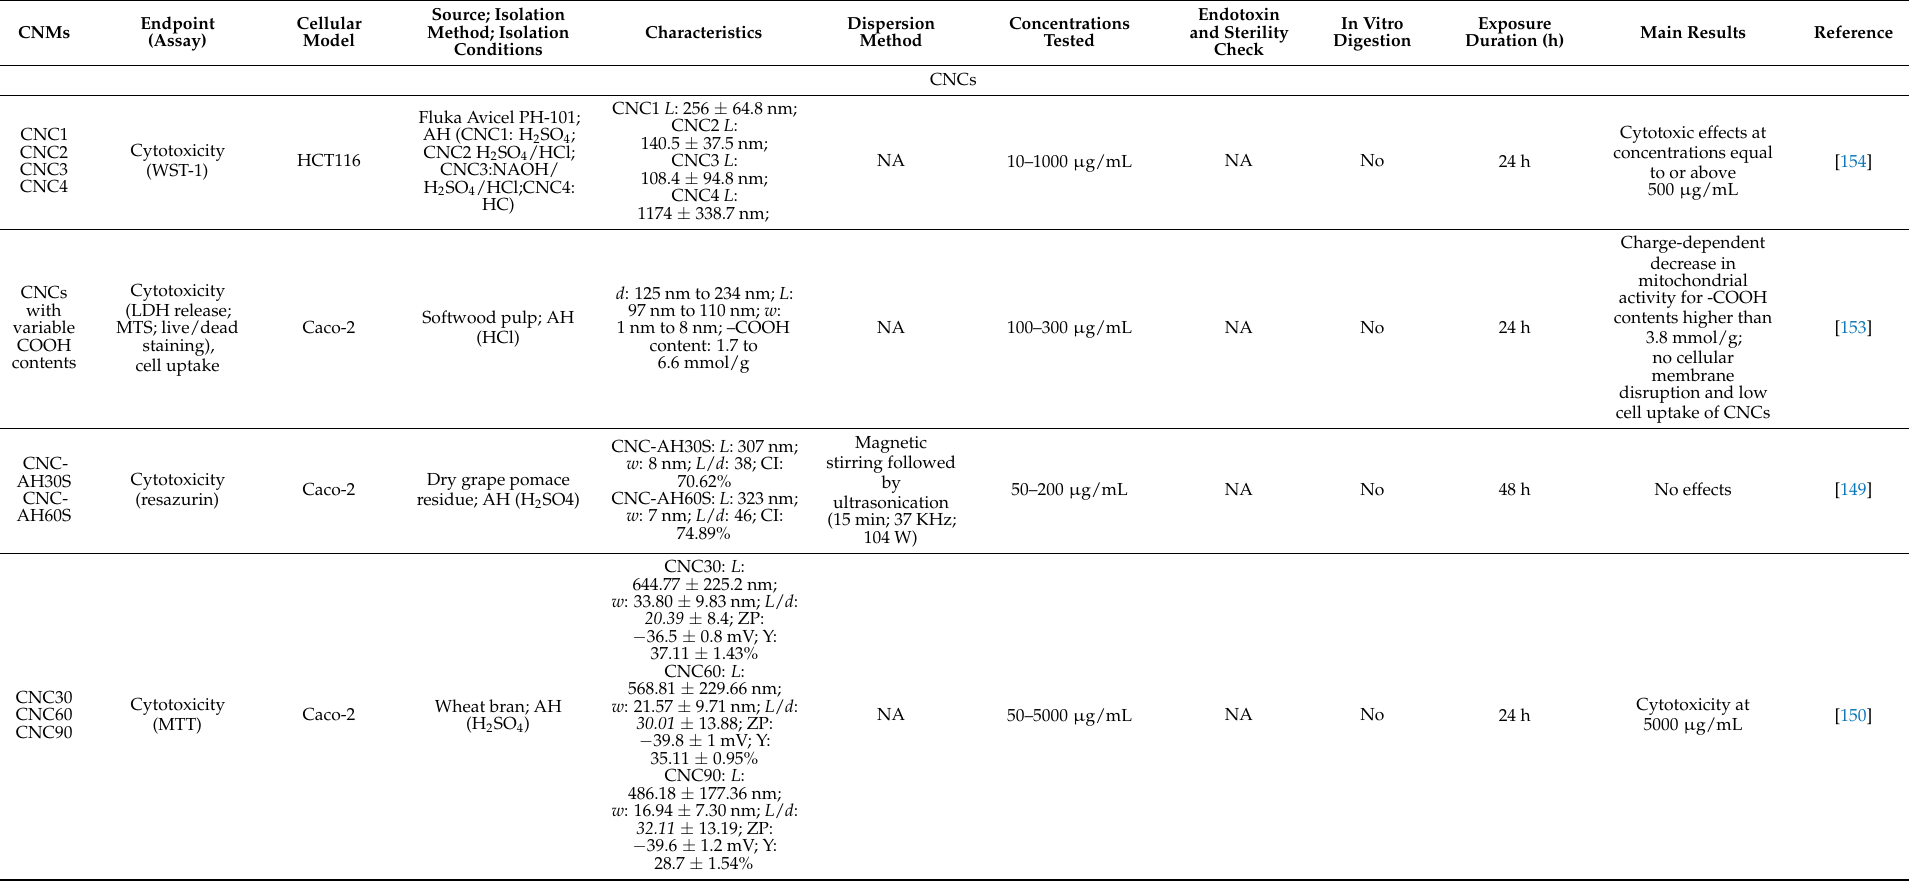
Table 2. In vitro toxicity assessment of CNMs in GIT cellular